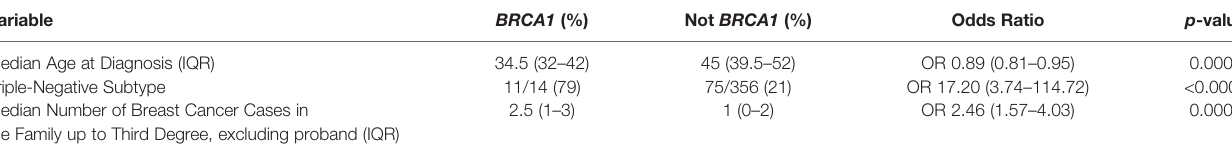
TABLE 3 | Multivariable